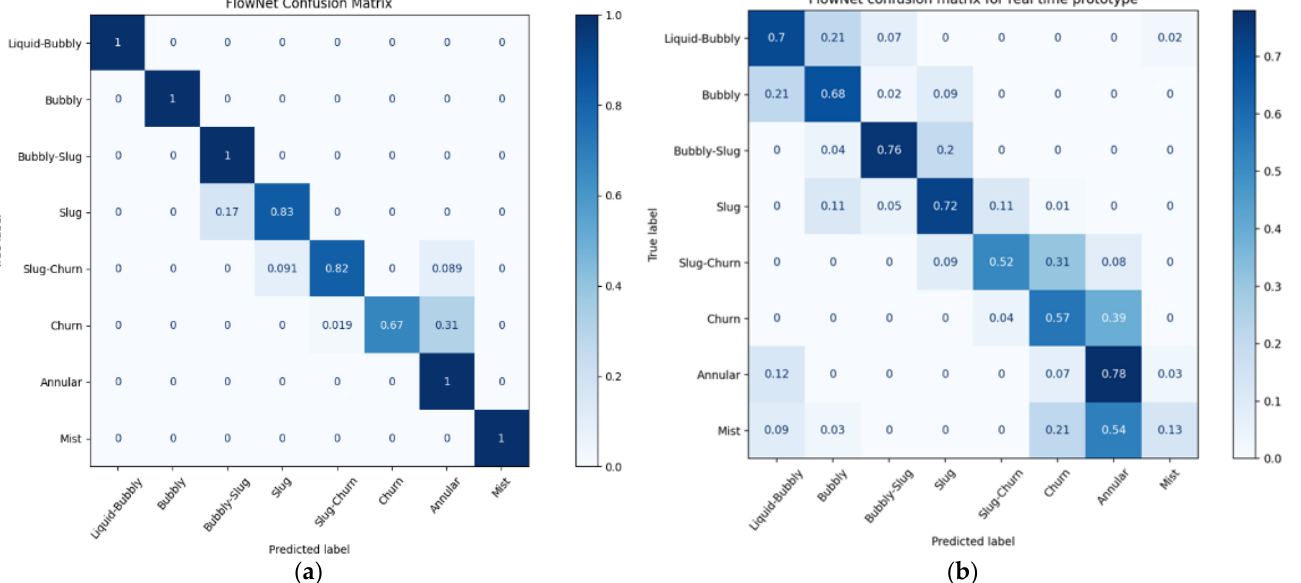
Figure 7. Normalized confusion matrices for FlowNet: ( a ) during offline testing; ( b ) during online testing using the experimental prototype.